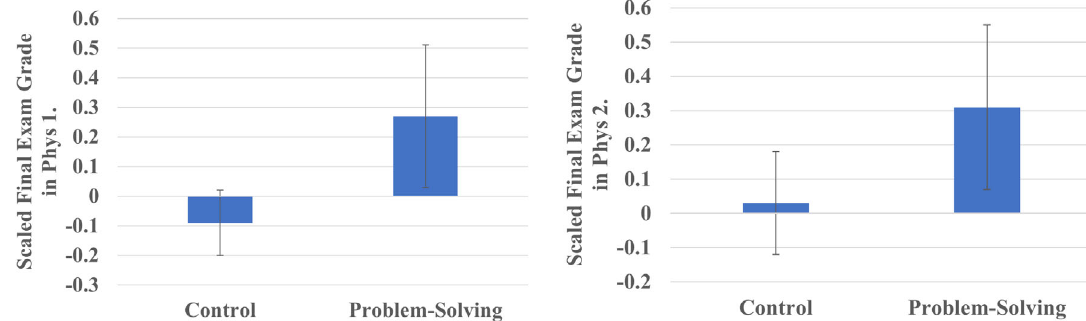
FIG. 2. Final exam grades converted to z scores ( “ Scaled Final Exam Grade ” ) while controlling for incoming physics preparation on the Physics 1 final (left) and the Physics 2 final (right). Comparison is between the control and problem-solving sections. Error bars represent standard